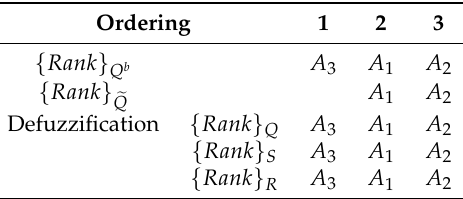
Table 10. Ranking by fuzzy